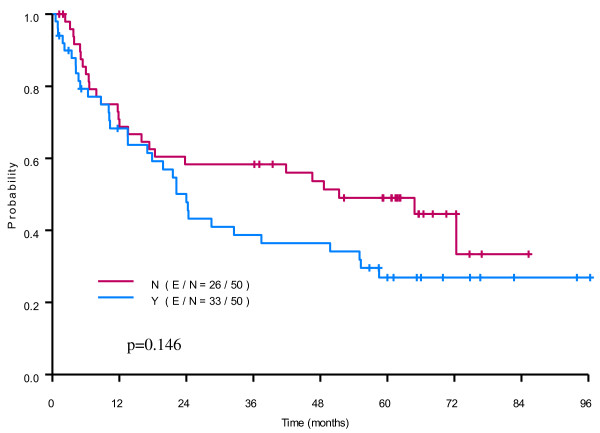
The Kaplan-Meier curve and p-value from stratified Cox proportional hazards model for RFS are depicted in the figure. Our analysis showed no association between blood transfusion and recurrence free survival.